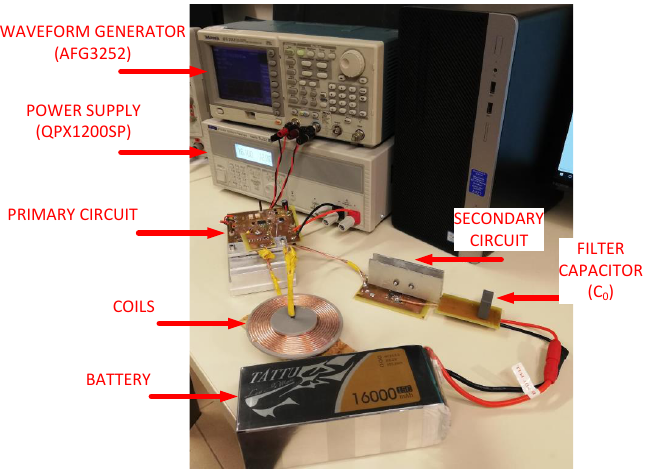
Figure 4. Photograph of the prototype developed to validate the simulations.